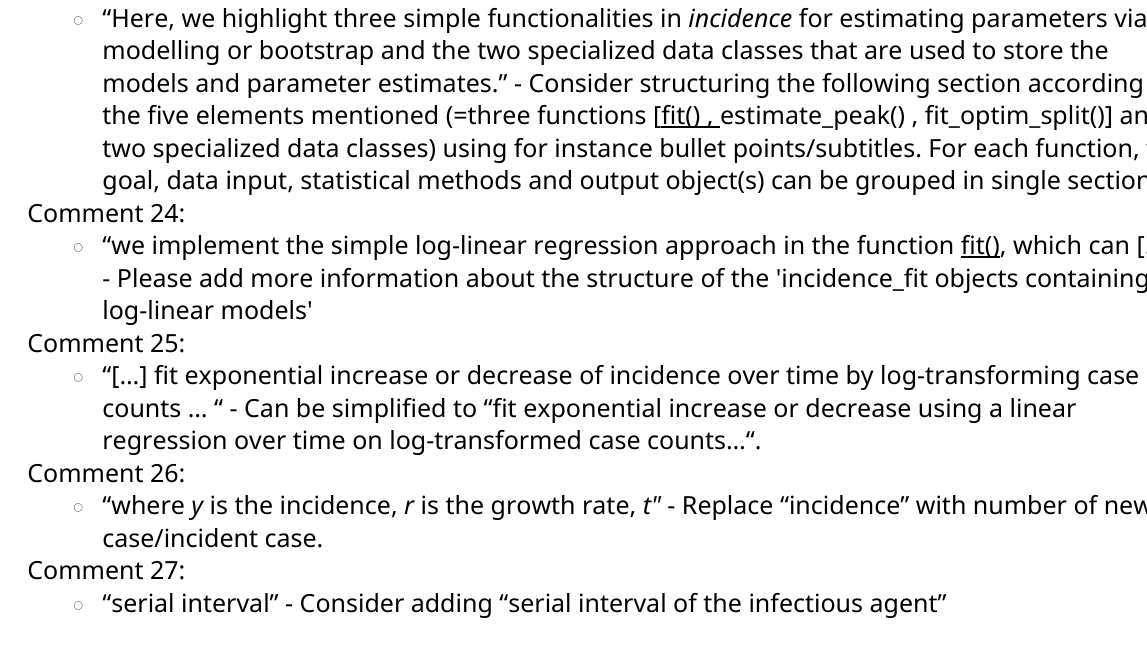
“Figure 1. Generalized workflow from incidence object construction to modeling and visualization.” - The first example in the paper is using a line-list format as data inputs but showed a stratified graphic. To be consistent and easier to follow for the reader, this figure illustrates the flow of such of data type, knowing that line-list is the primary source of epidemiological surveillance. A solution present in the figure is the two types of data inputs (non-aggregated/aggregated count). It would be easier, from a reader point of view, to capture the data flow from the line-lit to the final products proposed by this